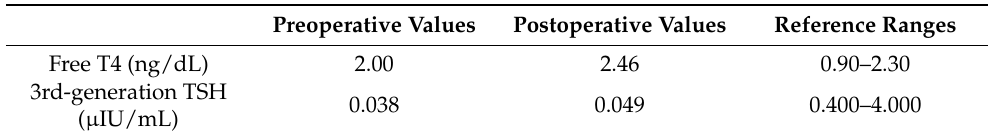
Table 2. Levels of preoperative and postoperative free T4 and TSH. On postoperative day 1, the level of free T4 increased compared to preoperative level. Abbreviations: free T4, free thyroxine; TSH, thyroid-stimulating hormone.